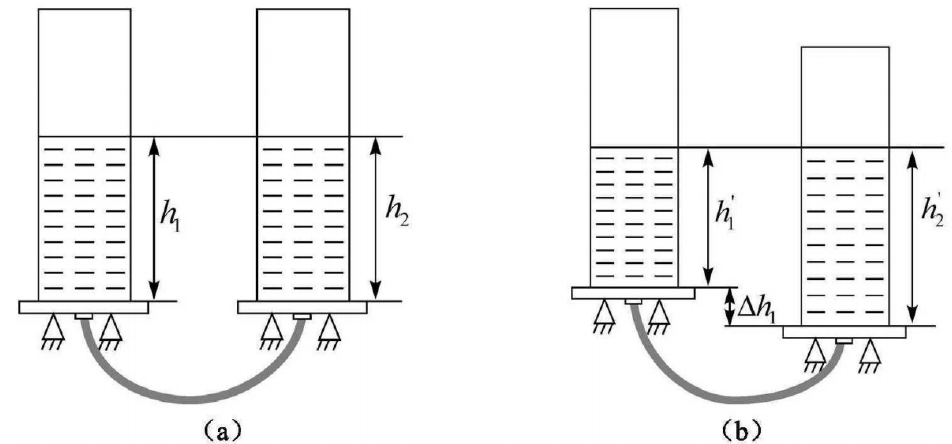
Figure 1. The principle of the static level. The original stage ( a ) and the new statement when the vertical displacement occurs ( b ).